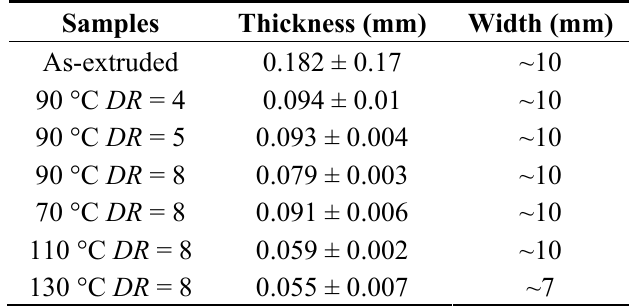
Table 3. Geometry of the specimens used for tensile